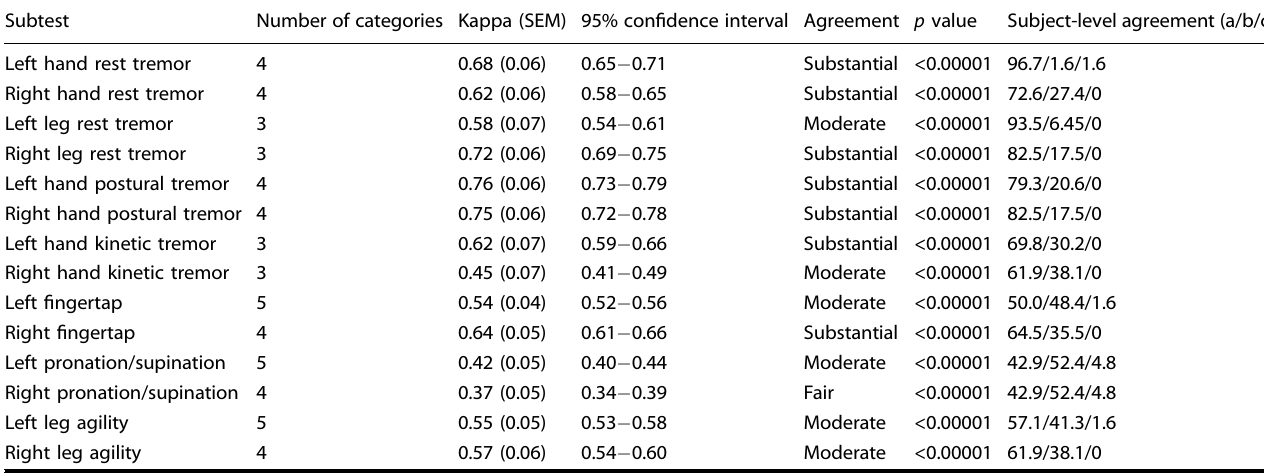
Table 2. Population-level and subject-level inter-rater agreement for clinical MDS-UPDRS III subscores. Subtest